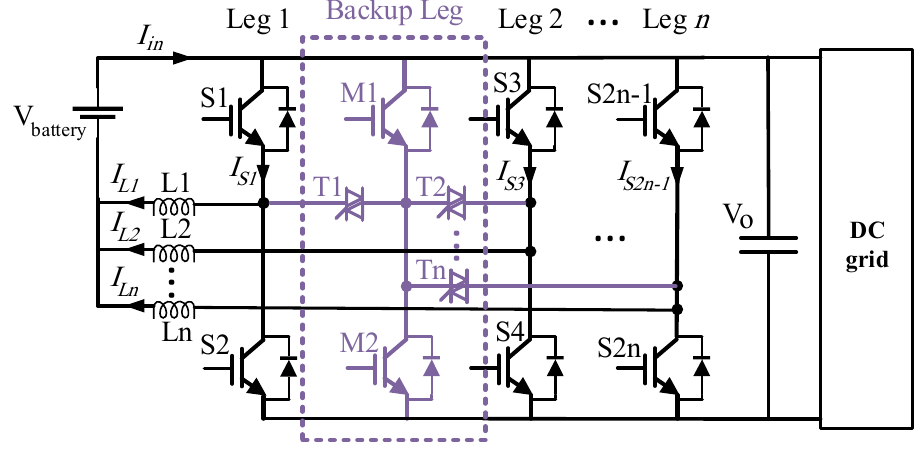
Figure 2. Battery energy storage system with open-circuit power switch fault-tolerant converter.